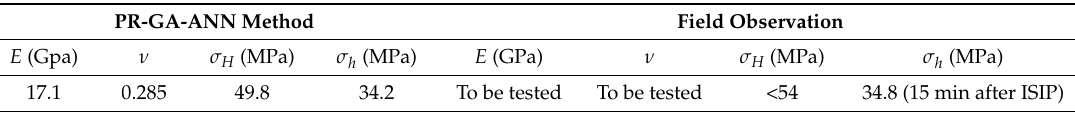
Table 3. Comparison of PR-GA-ANN back calculated rock mechanical properties and in-situ horizontal stresses with field observation in Lower Marcellus formation.